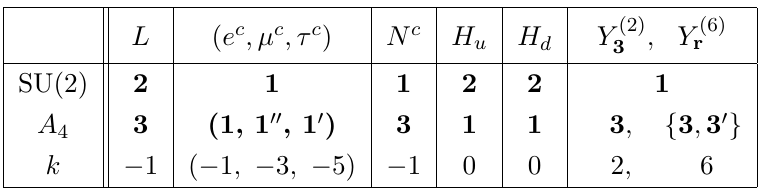
Table 4 . Representations and weights k for MSSM fields and modular forms of weights 2 and 6 .